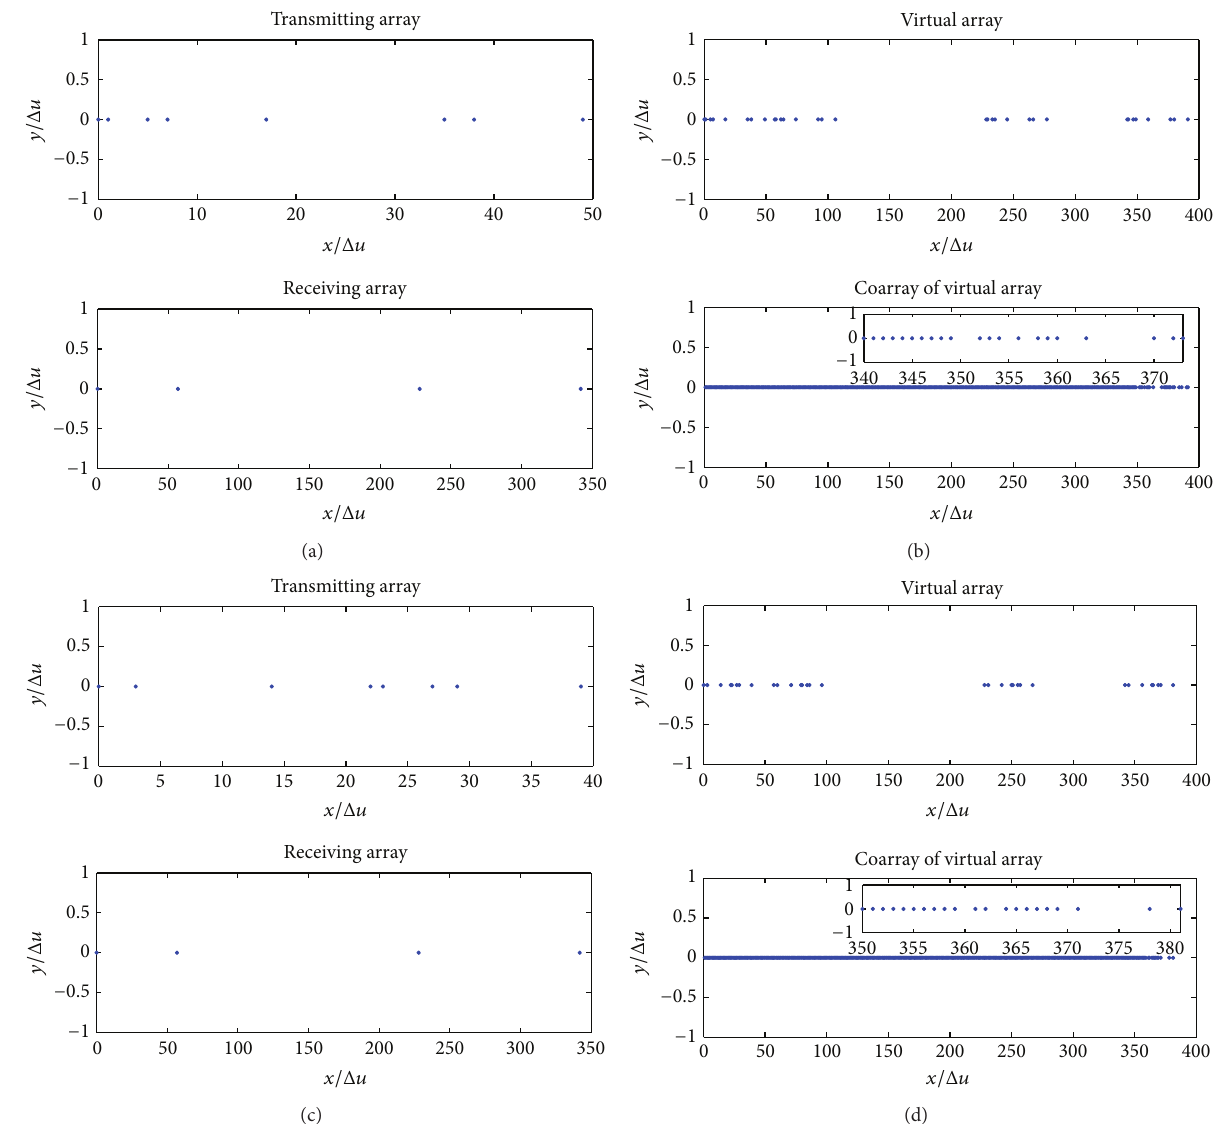
Figure 2: Illustration of an 8×4 MR-MIMO array synthesis from the initial CDS (the upper row) and the enumerative shifting procedure (the lower row); (a) and (c) the lattice location of the transmitting and receiving arrays; (b) and (d) the synthesized virtual array and its coarray.